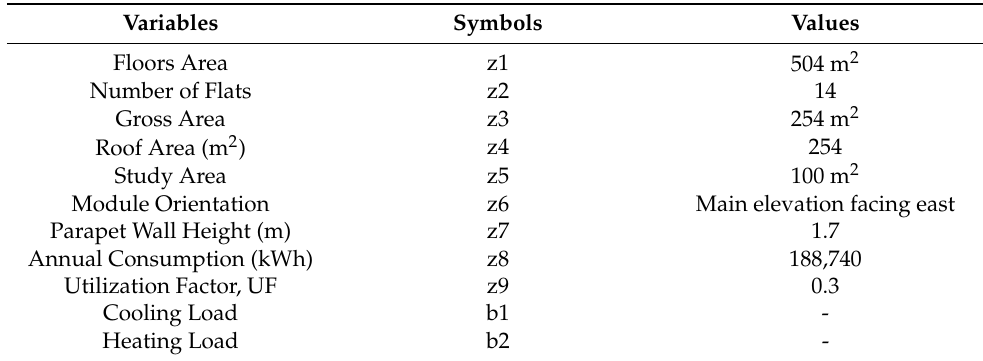
Table 1. Description of the case study’s input and output